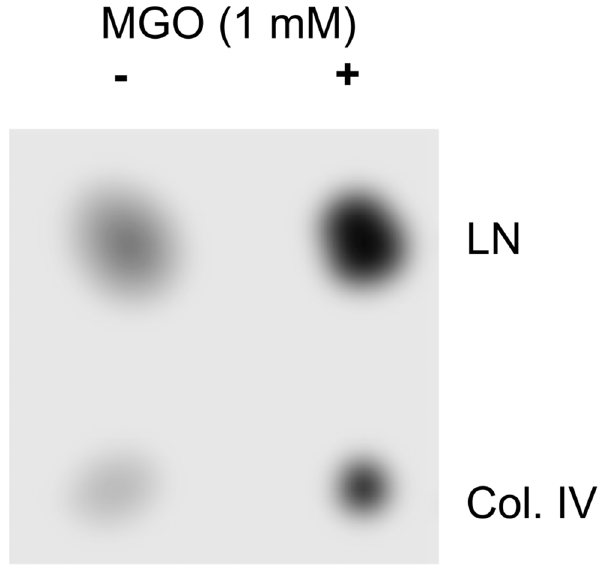
Figure 2. AGE modification of ECM proteins using MGO. 20 m g collagen IV (Col. IV) or laminin (LN) were spotted on a nitrocellulose membrane. One half of the membrane was incubated with 1 mM MGO for 4 hours. AGE formation was detected by dot blot analysis using the monoclonal CML26 antibody.